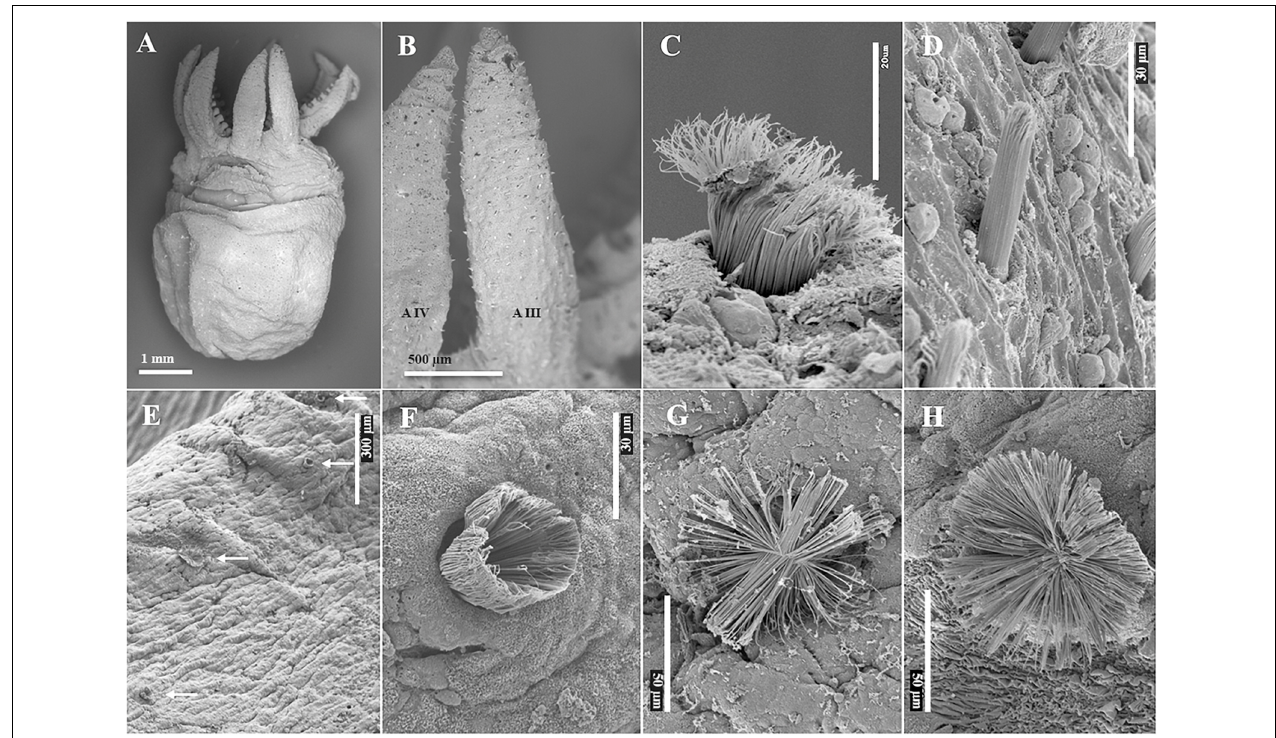
FIGURE 6 | Scanning Electron Microscopy images of hatchling Enteroctopus megalocyathus ( A,B , ML 3.8 mm; C,D , ML 5.3 mm) and wild benthic juvenile 16.8 mm ML Eledone cirrhosa (E–H) . (A) ventral view; (B) detail of left arms III (AIII) and IV (AIV), showing erupted Kölliker’s organs (KO); (C) semi-everted KO on dorsum of head; (D) erupted KO on dorsal surface of right arm II. (E) Semi-erupted and everted KO (white arrows) on left arm III; (F) details of semi-erupted KO; (G,H) fully everted